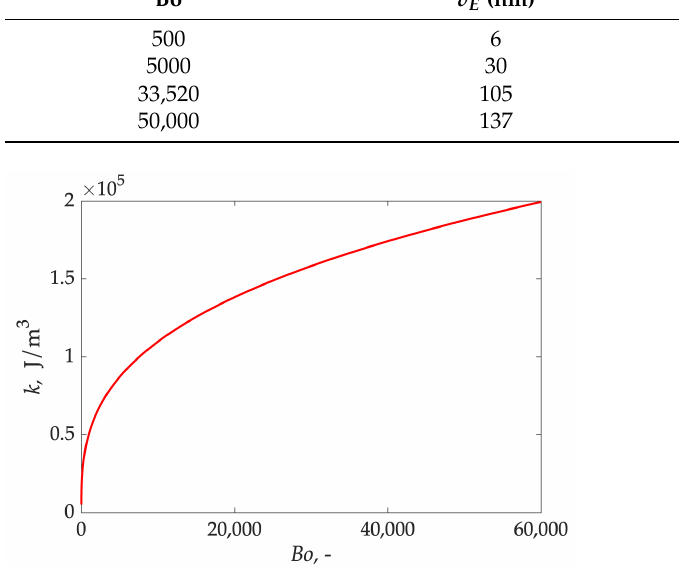
Figure 2. Relationship between the cohesion energy density and the Bond number.